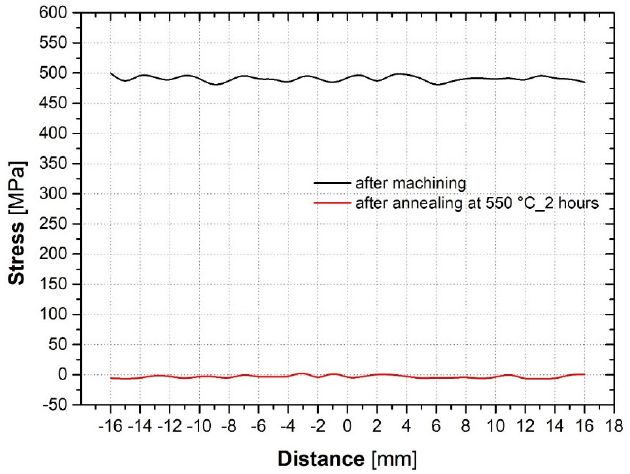
Figure 5. Residual stresses after machining (black curve) and after annealing (red curve).